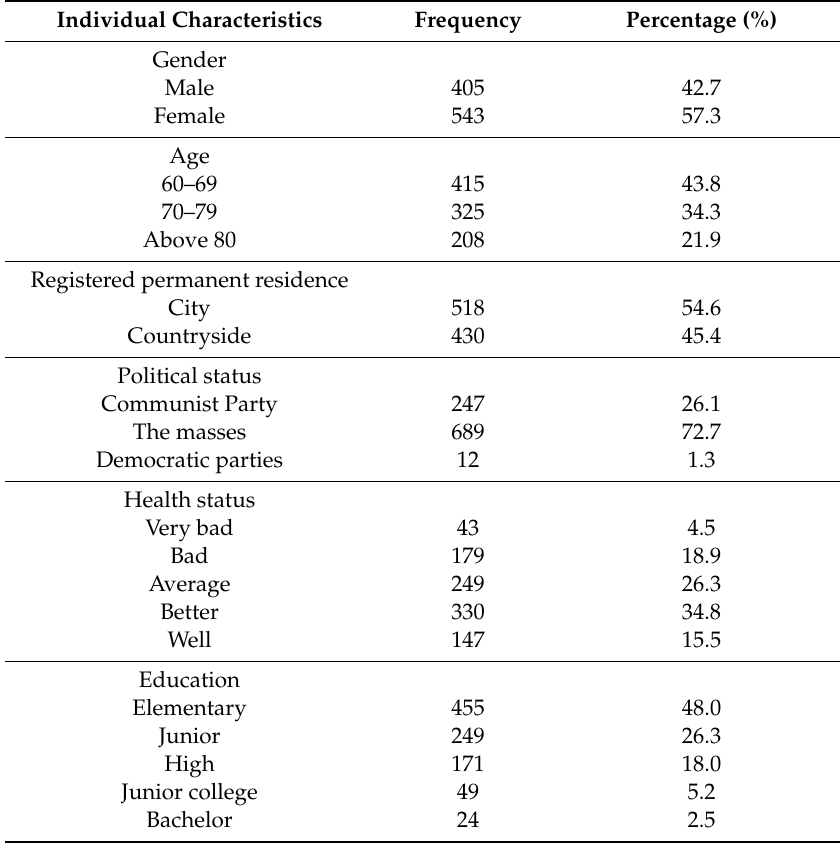
Table 3. Descriptive statistics of the